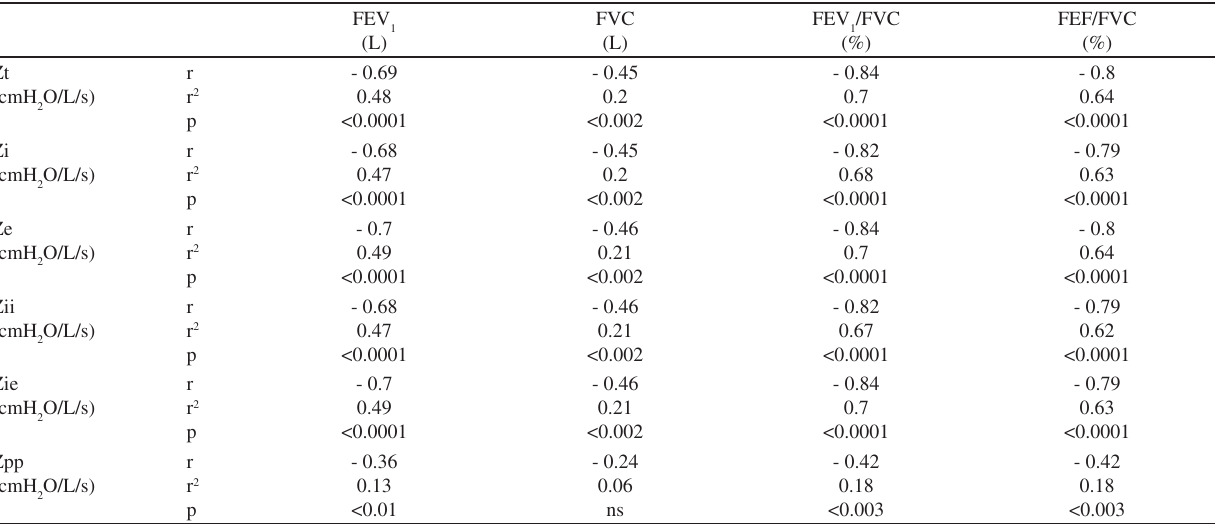
Table 1 - Anthropometric and spirometric characteristics of the study